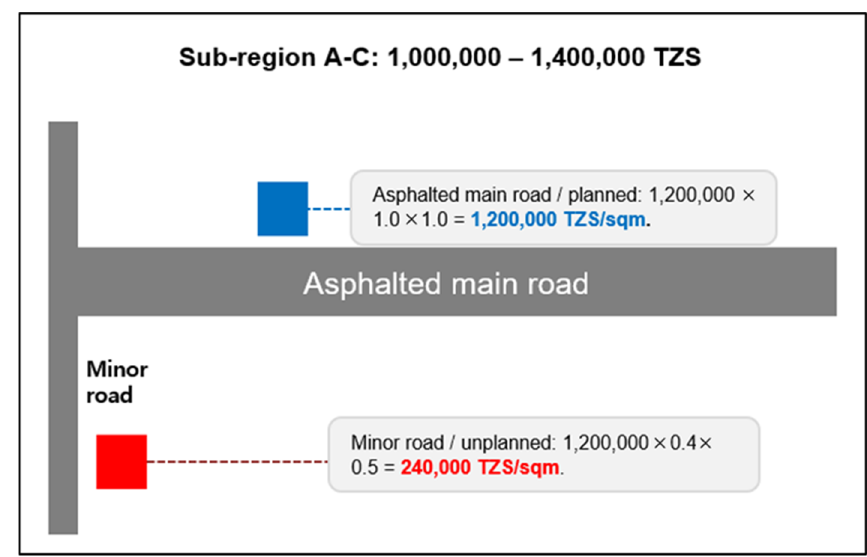
Figure 1. Example of mass assessment using land value and land price ratio tables.